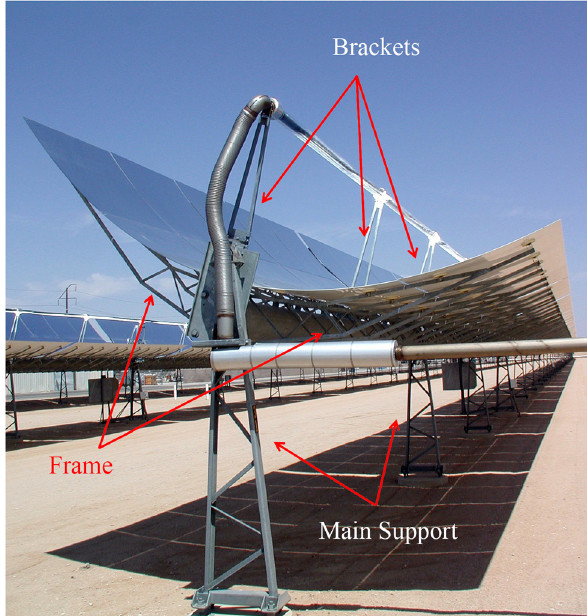
Figure 5: Structural division of a PTC. ( Retrieved from the NREL website: https://images.nrel.gov.